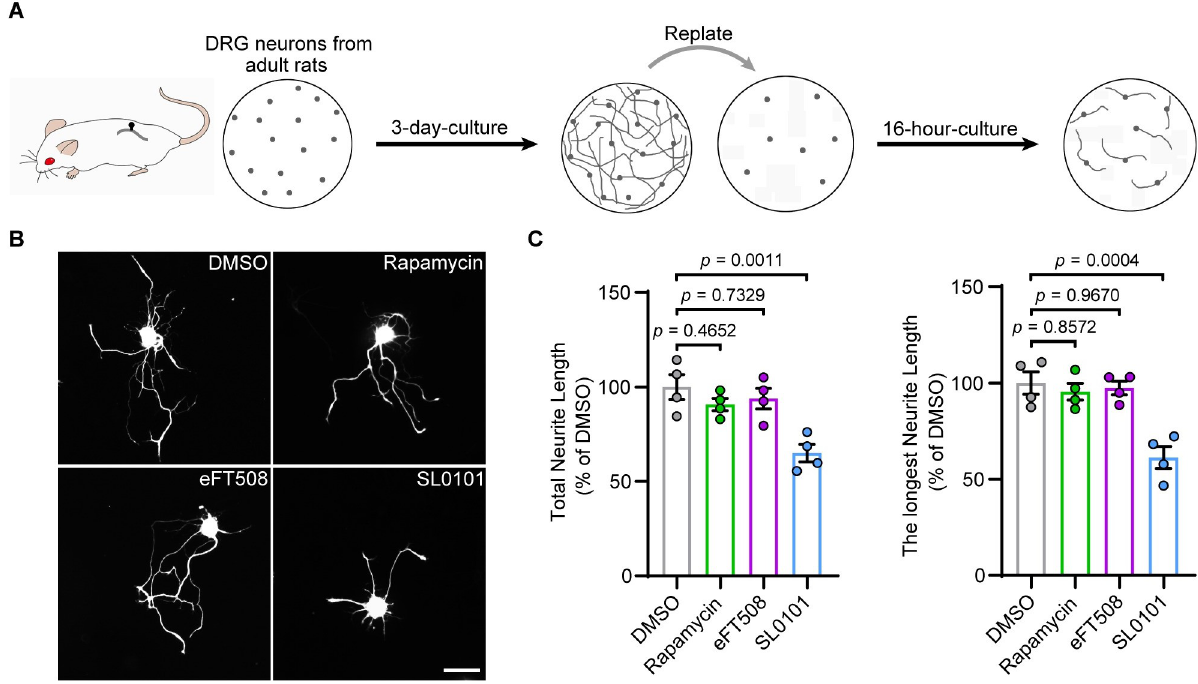
Fig 1. SL0101 inhibits DRG neuron regenerative growth. (A) Schematic of the culture-and-replate protocol. DRG neurons were dissociated from adult rats and cultured for 3 days. Neurons were then replated to reinitiate axon growth. Regenerative axon growth was assessed by measuring axon length in replated neurons 16 hours after replating. (B) Representative images of cultured DRG neurons treated with DMSO, 50 nM rapamycin, 1 μ M eFT508, and 10 μ M SL0101. Scale bar, 50 μ m. (C) Quantification of the total and the longest neurite outgrowth per neuron relating to (B) (mean ± SEM, 1-way ANOVA, Dunnett post hoc test, n = 4 biologically independent experiments, approximately 50 cells/experiment on average). The data underlying all the graphs shown in the figure are included in S1 Data. D AU : AbbreviationlistshavebeencompiledforthoseusedthroughoutFigs 1 (cid:0) 8 : Pleaseverifythatallentriesarecorrect : RG, dorsal root ganglion; SEM, standard error of the mean.